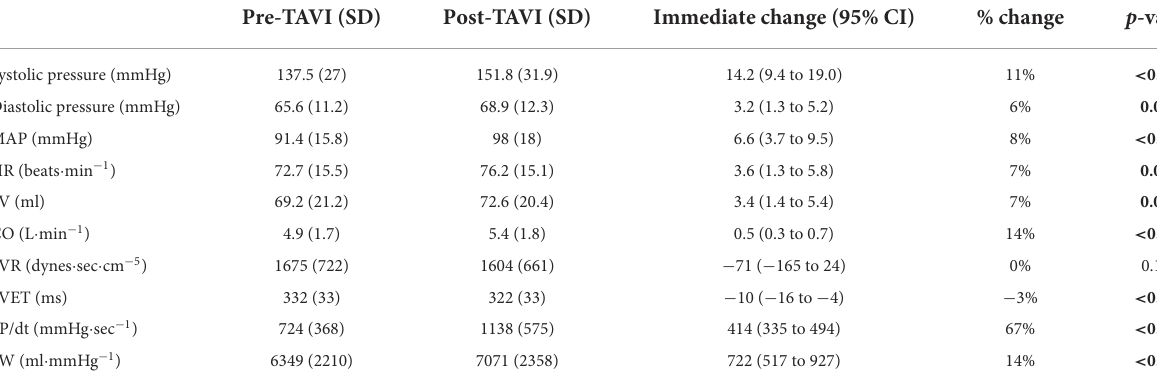
TABLE 3 Immediate hemodynamic changes following TAVI.